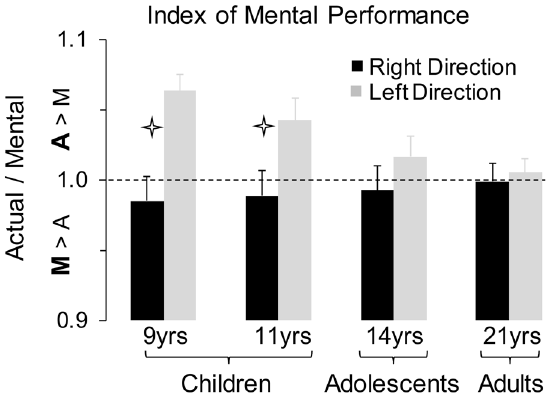
Figure 4. Average values ( + SE) of the index of mental performance (M/P) for the four age-groups. Stars indicate significant differences between right and left directions.